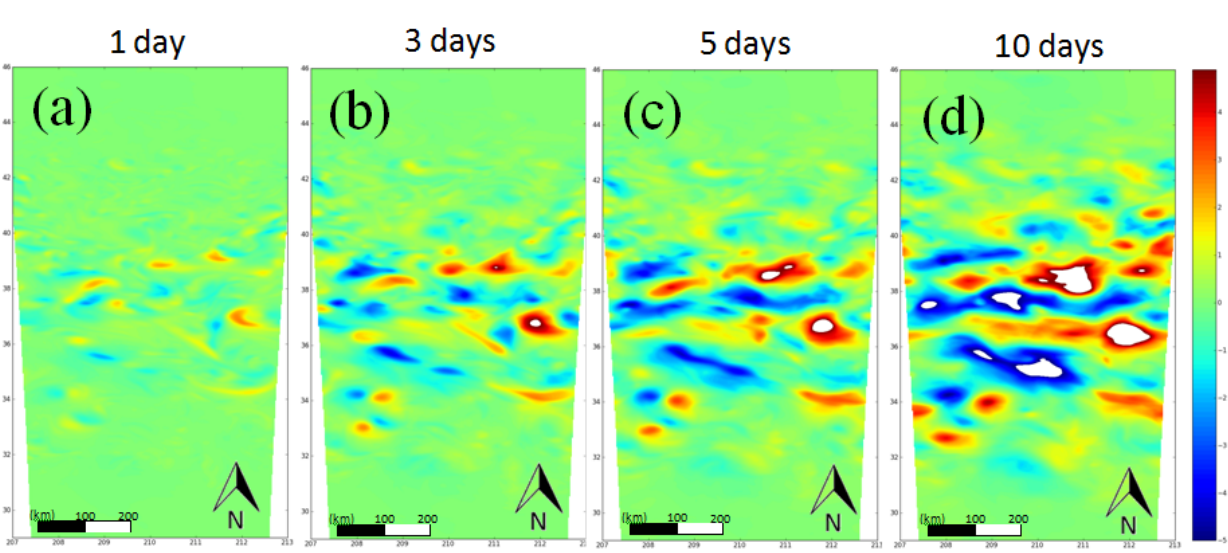
Figure 6. Example of ocean surface topography variability derived from the model from Klein et al. [8]: amplitude of the difference between two arbitrary model snapshots